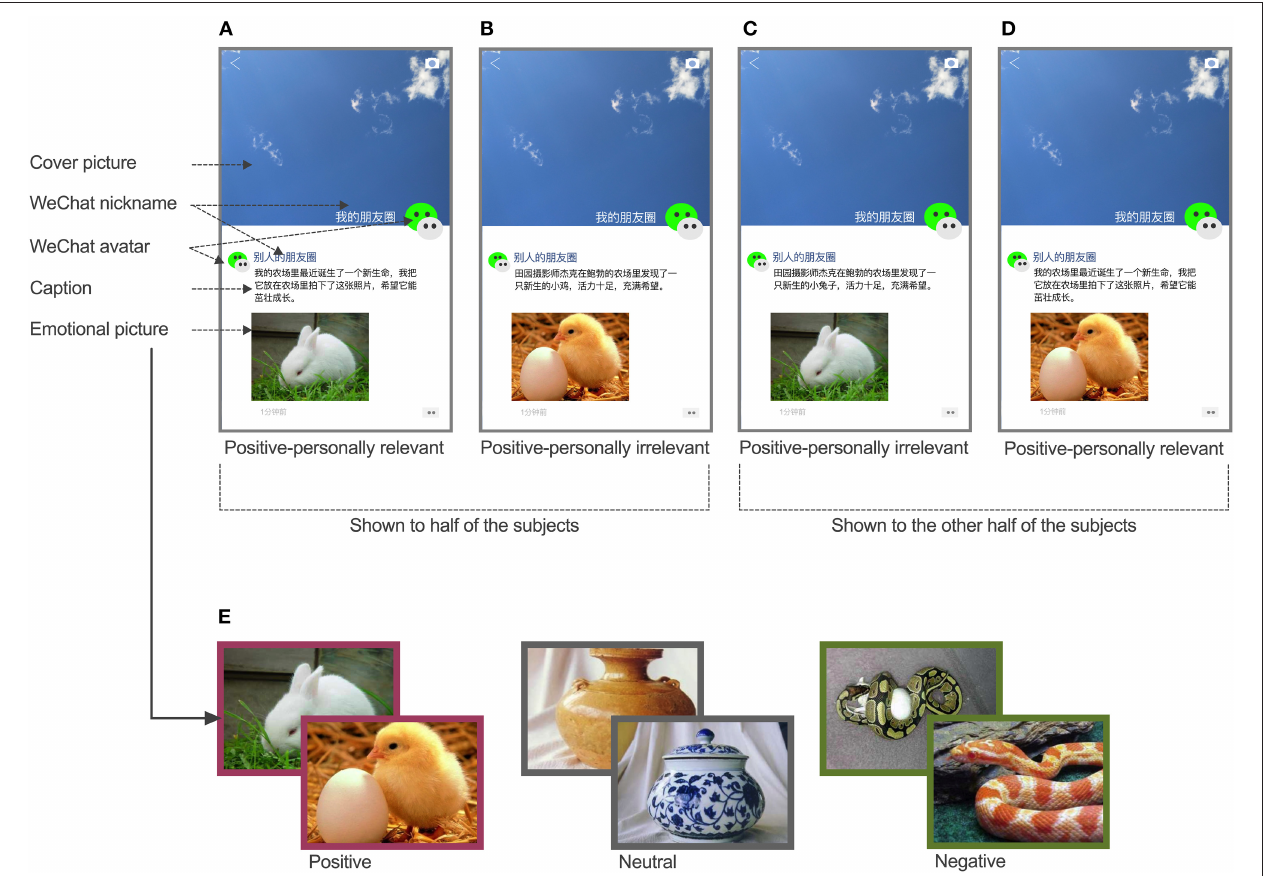
FIGURE 1 | Examples of simulated Moments images and emotional pictures. A pair of positive emotional pictures of similar situations were matched with two types of captions, personally relevant captions (A,D) or personally irrelevant captions (B,C) . Half of the participants in the extrovert and introvert groups were shown (A) and (B) during the experimental task, while the other half of the participants were shown (C) and (D) . (E) Examples of emotional pictures. Three sets of positive, neutral, and negative pictures, respectively. “ 我 的 朋 友 圈 ”: “My Moments”; “ 别 人 的 朋 友 圈 ”: “Other’s Moments”; (A) : “ 我 的 农 场 里 最 近 诞 生 了一个 新 生 命 , 我把 它 放 在 农 场 里 拍 下 这 张 照 片 , 希 望 它 能 茁 壮 成 长 。 ” (“A new life was born recently. I put it on my farm and took this picture. I hope it will thrive.”); (B) : “ 田 园 摄 影 师 杰 克 在 鲍 勃 的 农 场 里 发 现 了一 只 新 生 的 小 鸡 , 活 力 十 足 , 充 满 希 望 。 ” (“Jack, a field photographer, found a newborn chick on Bob’s farm with great vigor and hope.”); (C) : “ 田 园 摄 影 师 杰 克 在 鲍 勃 的 农 场 里 发 现 了一 只 新 生 的 小 兔 子 , 活 力 十 足 , 充 满 希 望 。 ” (“Jack, a field photographer, found a newborn rabbit on Bob’s farm with great vigor and hope.”); (D) : “ 我 的 农 场 里 最 近 诞 生 了一个 新 生 命 , 我把 它 放 在 农 场 里 拍 下了 这 张 照 片 , 希 望 它 能 茁 壮 成 长 。 ” (“A new life was born recently. I put it on my farm and took this picture. I hope it will thrive.”). (Images retrieved with permission from: Chinese Affective Picture